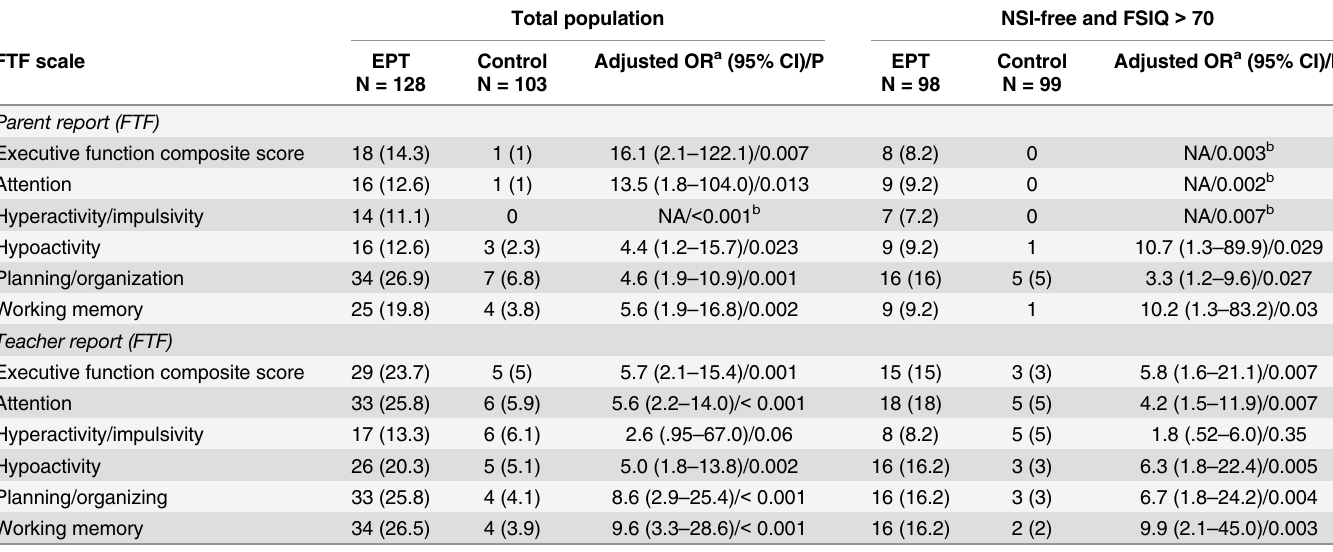
Table 4. Proportion of children in each group scoring in the clinical range ( > 2 SD above the mean) on behavioral parameters of EF. Total population NSI-free and FSIQ >